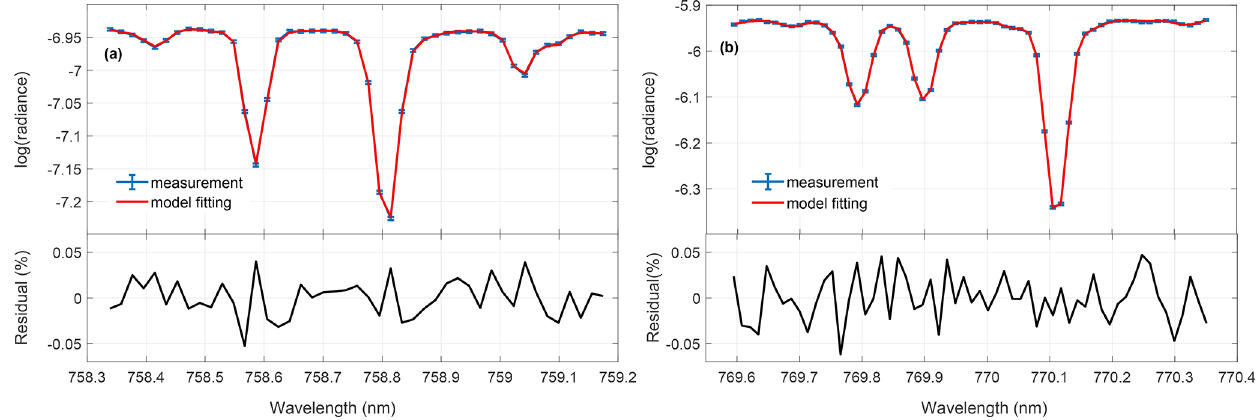
Figure 1. The fitted spectra and residuals for the (a) 757nm and (b) 771nm micro-windows of TanSat measurement. The error bar of the measured spectra depicts the estimated precision of each TanSat